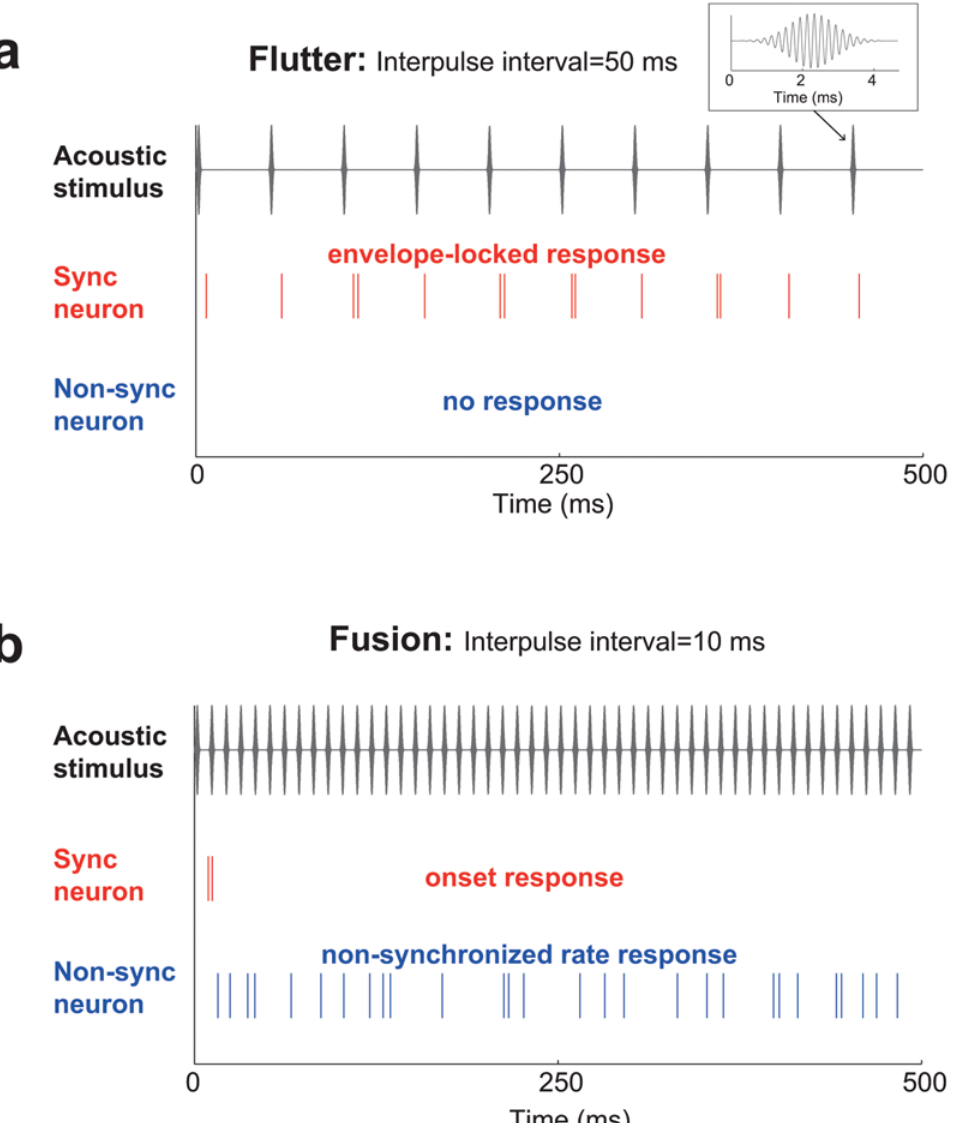
Fig 1. Schematic of synchronized and non-synchronized responses from auditory cortical neurons in response to acoustic pulse trains generating flutter and fusion percepts. Each plot is subdivided (from top to bottom) into an illustration of the acoustic pulse train (gray), and the evoked neural response from synchronized neurons (red) and non-synchronized neurons (blue). The inset plot in (a) shows a single acoustic pulse (5 kHz carrier frequency). a. An acoustic pulse train generating a flutter percept (interpulse interval = 50 ms). b. An acoustic pulse train generating a fusion percept (interpulse interval = 10